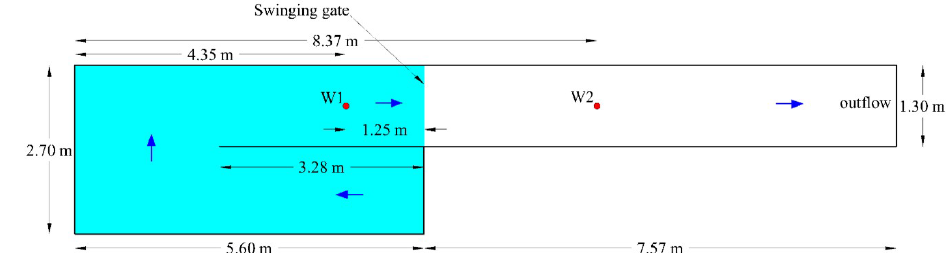
Figure 27. Experimental model of St-Germain et al. (2012).